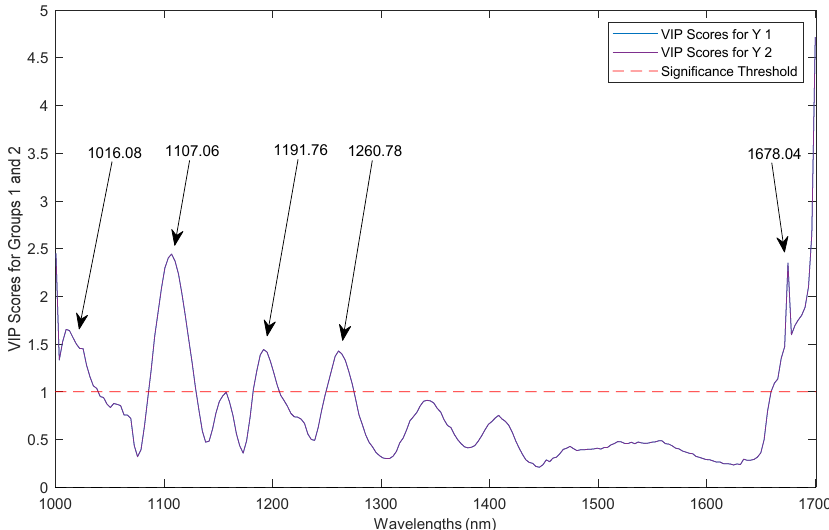
Figure 8. VIP scores for the two classification categories.